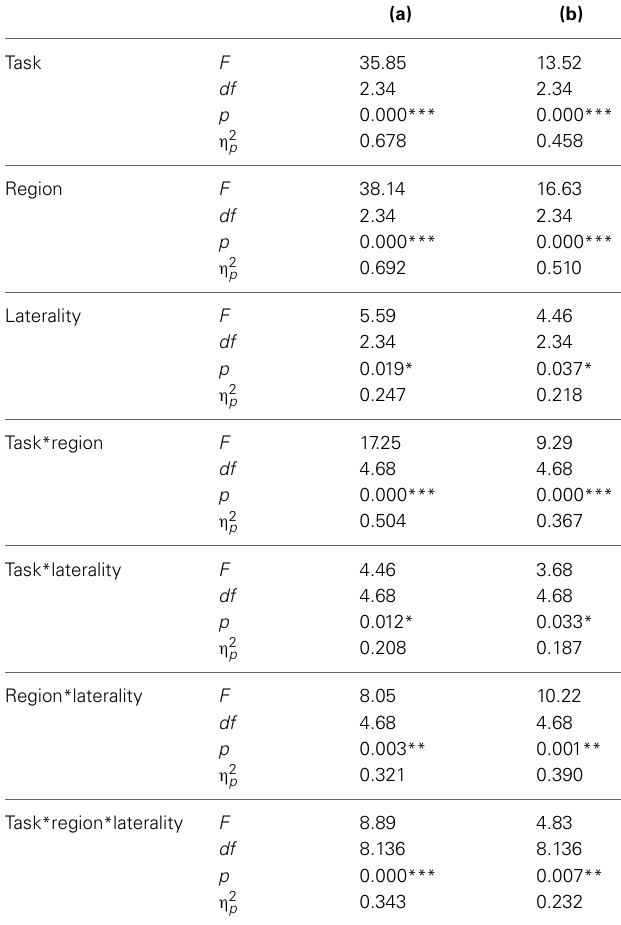
Table 4 | Results of the repeated ANOVA including the factors: task (ignore, passive, focused), region (frontal, central, parietal) and laterality (left, middle, right), within the N400 time range, of the (a) word priming paradigm and of the (b) sentences